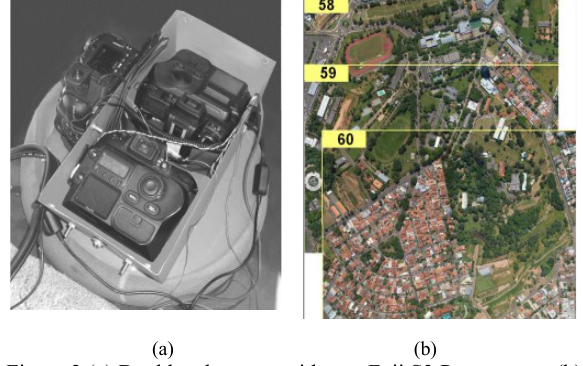
Figure 2.(a) Dual head system with two Fuji S3 Pro cameras (b) example of virtual images generated with the dual system.